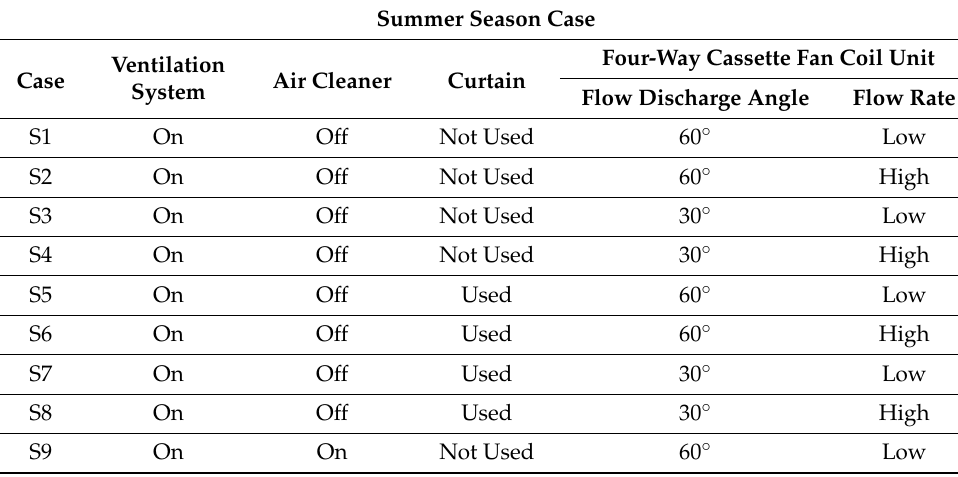
Table 1. Cases for cooling mode of the four-way cassette fan coil unit in summer.